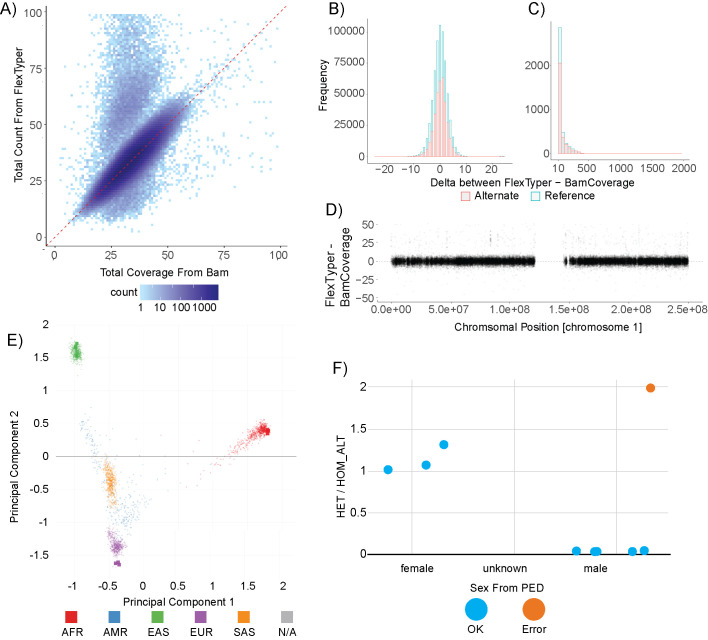
WGS Genotyping using FlexTyper.A) FlexTyper read count compared to the total coverage from BAM file over SNP sites represented on the CytoScanHD microarray. B) Histogram showing the delta, (Δ = FlexTyper—BamCoverage), in read count for both the alternate (red) and reference (blue) alleles. C) Histogram of the same delta as B) but with an extended axis from 100–2000, showing the frequency of over-counting for sites using FlexTyper. D) Scatter plot showing the delta (Δ = FlexTyper—BamCoverage) on the y-axis, plotted across chromosome 1 on the x-axis. E) Principal component analysis showing projection of FlexTyper-derived SNP genotypes from nine individuals of Asian (green), African (red) and European (purple) ancestry. Squares denote FlexTyper genotypes, points denote existing data from the 1000 Genomes project provided by Peddy. F) Sex-typing for these Polaris samples showing the ratio of heterozygous to homozygous sites on the X chromosome (y-axis) for individuals for the defined sexes as male (right) and female (left). Each individual is labeled as green (correctly sex-labeled) or red (incorrectly labeled).